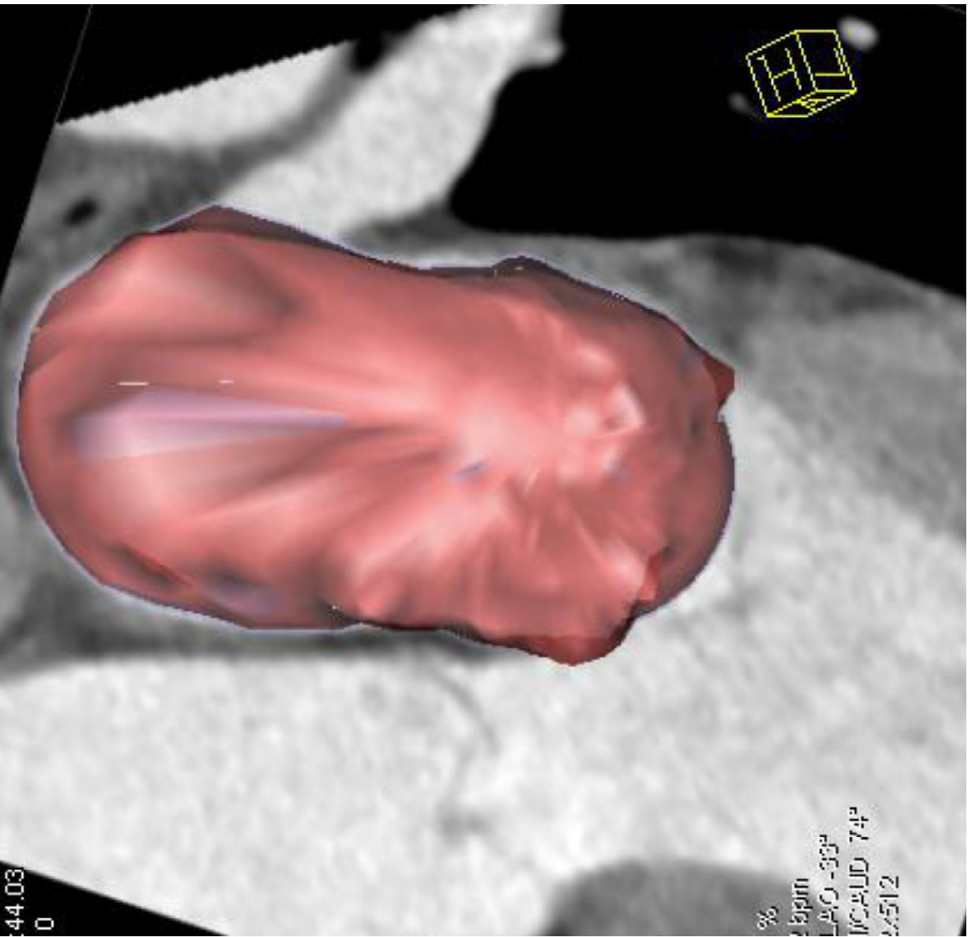
Fig 2. 2D and 3D fusion image of LA. The fusion image providing true 3D rendering of LA without taking any geometrical